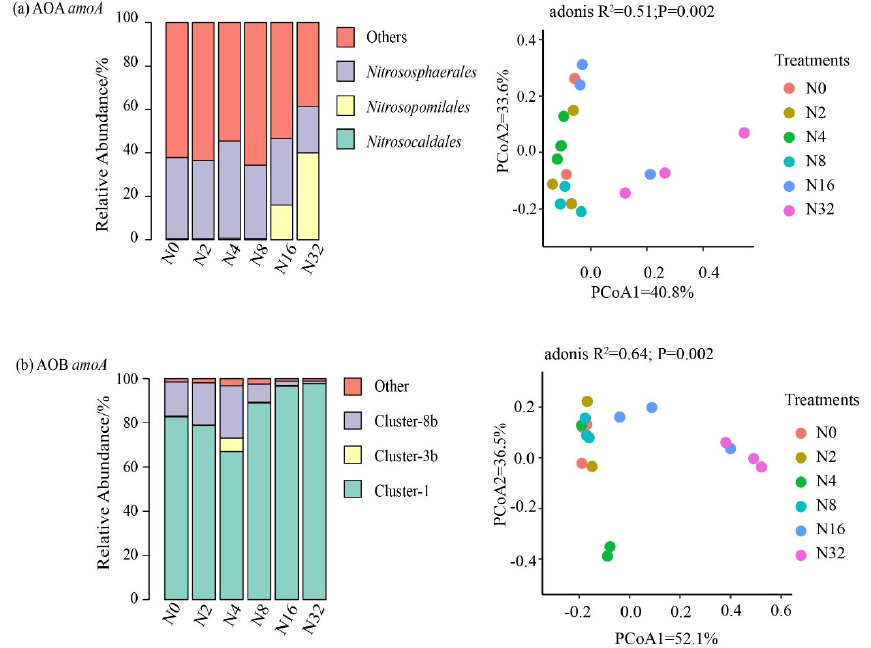
Figure 3. The relative abundances of nitrifier community compositions and principal coordinates analysis (PCoA) based on the Bray–Curtis distance. ( a ) AOA amoA , and ( b ) AOB amoA . N0 is the control (0 g N ∙ m − 2 ∙ yr − 1 application), N2 is the 2 g N ∙ m − 2 ∙ yr − 1 application, N4 is the 4 g N ∙ m − 2 ∙ yr − 1 application, N8 is the 8 g N ∙ m − 2 ∙ yr − 1 application, N16 is the 16 g N ∙ m − 2 ∙ yr − 1 application, and N32 is the 32 g N ∙ m − 2 ∙ yr − 1 application.